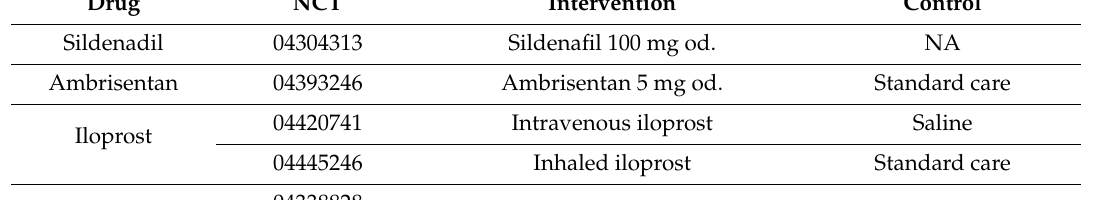
Table 2. The most relevant current clinical trials exploring the e ff ectiveness of specific therapies for pulmonary hypertension in COVID-19 (source: